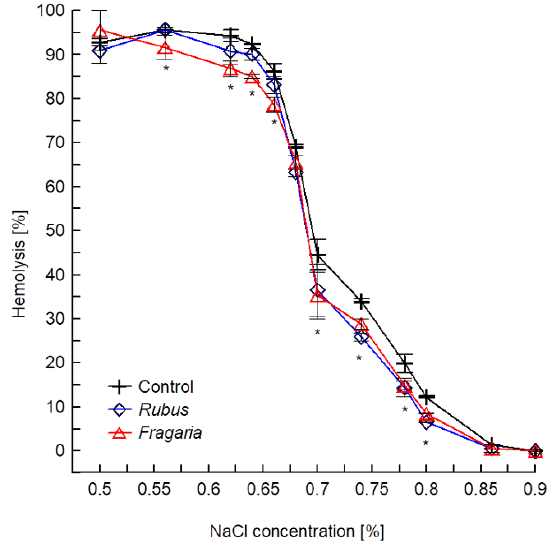
Figure 3. Percentage of haemolysis in Rubus and Fragaria- modified cells in hypotonic and isotonic solutions of sodium chloride. The extracts were used at 10 µ g/mL concentration and the measurement was done at room temperature. Statistically significant difference between results of control and extracts modified samples are denoted (*α = 0.05).